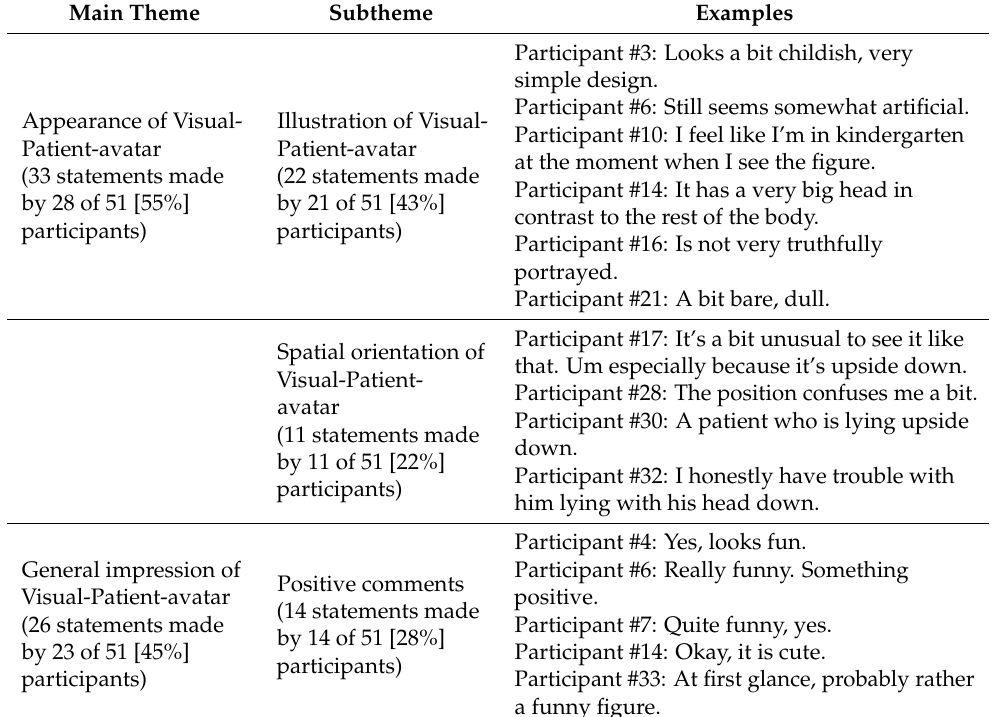
Table 2. Main themes/subthemes with statement count and exemplary responses. N = 51